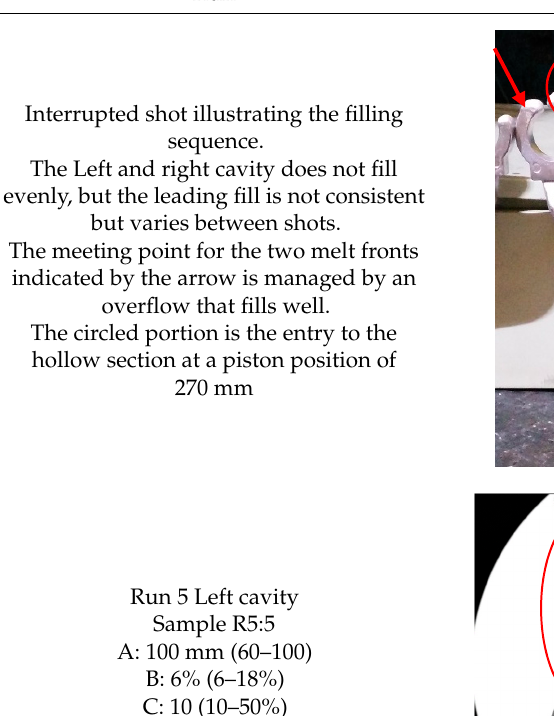
crack would be oriented in the 45% direction to this main stress direction if the material is Table 3. The most common defect and their location, as well as an illustration from interrupted reasonably ductile. This is also the case for the current defect illustrated. shots. The numbers are the settings for the different runs with A-First phase switch point, B-First phase speed and C-Intensification pressure. The number in the bracket is the range for the setting Table 3. The most common defect and their location, as well as an illustration from interrupted shots. to gauge if the value is high or low. (Black square is placed due to confidentiality of the product The numbers are the settings for the different runs with A-First phase switch point, B-First phase owner). speed and C-Intensification pressure. The number in the bracket is the range for the setting to gauge Table 3. The most common defect and their location, as well as an illustration from interrupted Table 3. The most common defect and their location, as well as an illustration from interrupted shots. The numbers are the settings for the different runs with A-First phase switch point, B-First shots. The numbers are the settings for the different runs with A-First phase switch point, B-First if the value is high or low. (Black square is placed due to confidentiality of the product owner). phase speed and C-Intensification pressure. The number in the bracket is the range for the setting phase speed and C-Intensification pressure. The number in the bracket is the range for the setting to gauge if the value is high or low. (Black square is placed due to confidentiality of the product to gauge if the value is high or low. (Black square is placed due to confidentiality of the product owner).